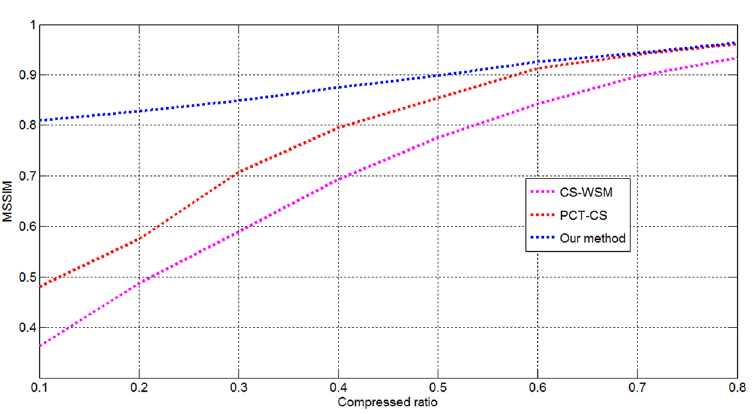
Figure 5. MSSIM values at different compression